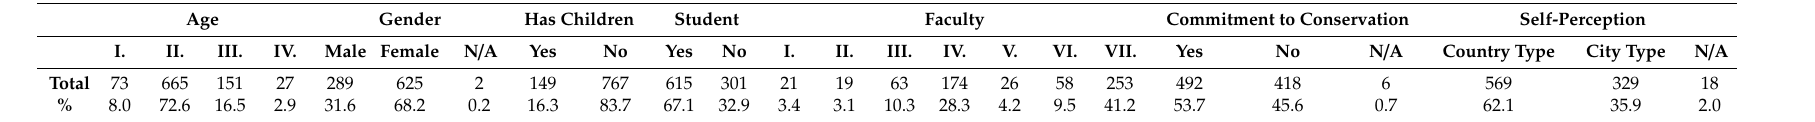
Table 1. Categories with regard to sociodemographic data and number of assigned survey